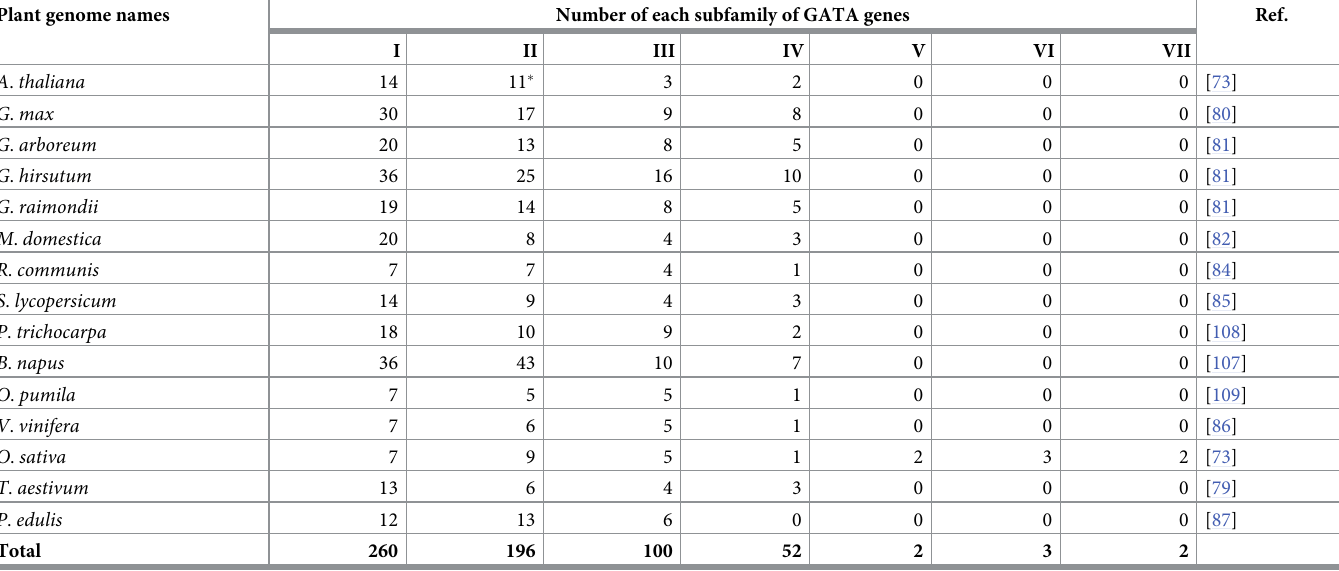
Table 3. Number of each subfamily of GATA genes in plants analyzed GATA gene family. Plant genome names